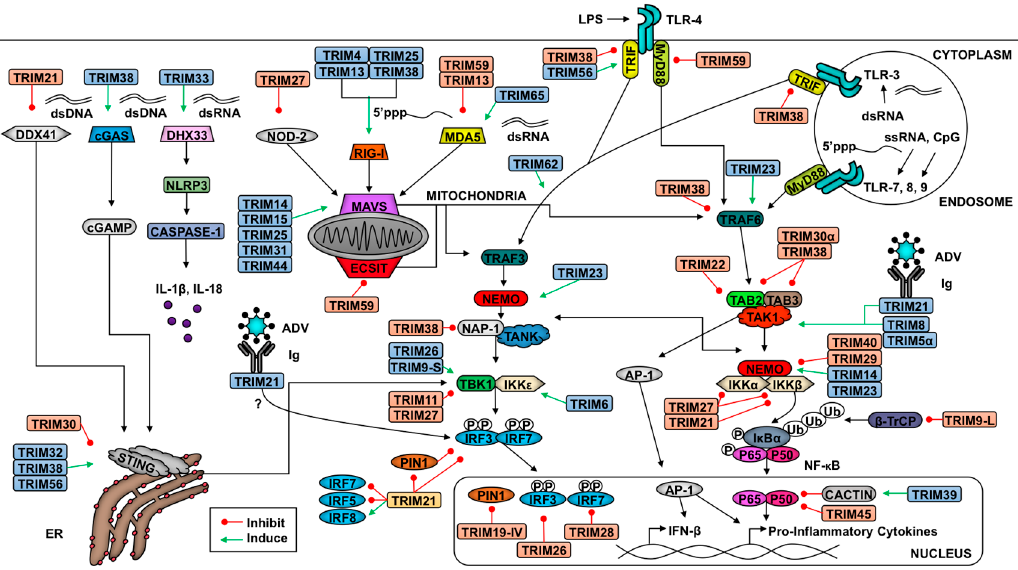
Figure 1. Regulation of pattern recognition receptor (PRR) signaling by tripartite motifs (